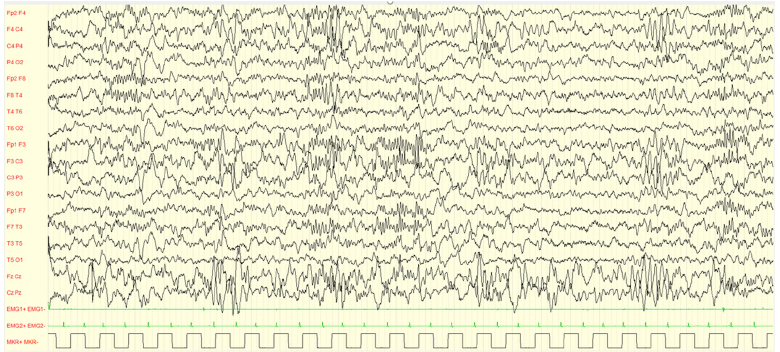
Figure 4. Male, 4 years PSG-EEG: background activity in sleep characterized by asynchronous and/or asymmetrical spindles and by K-complexes of irregular morphology with mixed paroxysmal slow waves.